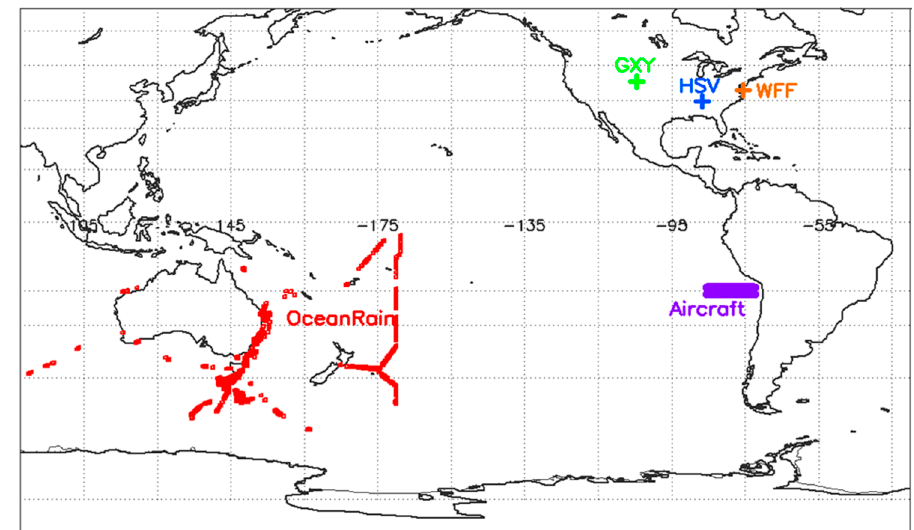
Figure 1. Locations of sites where MPS and 2DVD were deployed for Ground Validation. The purple rectangle depicts the region penetrated by the C-130. The red lines depict the tracks of the R/V Investigator in 2016 and 2018.